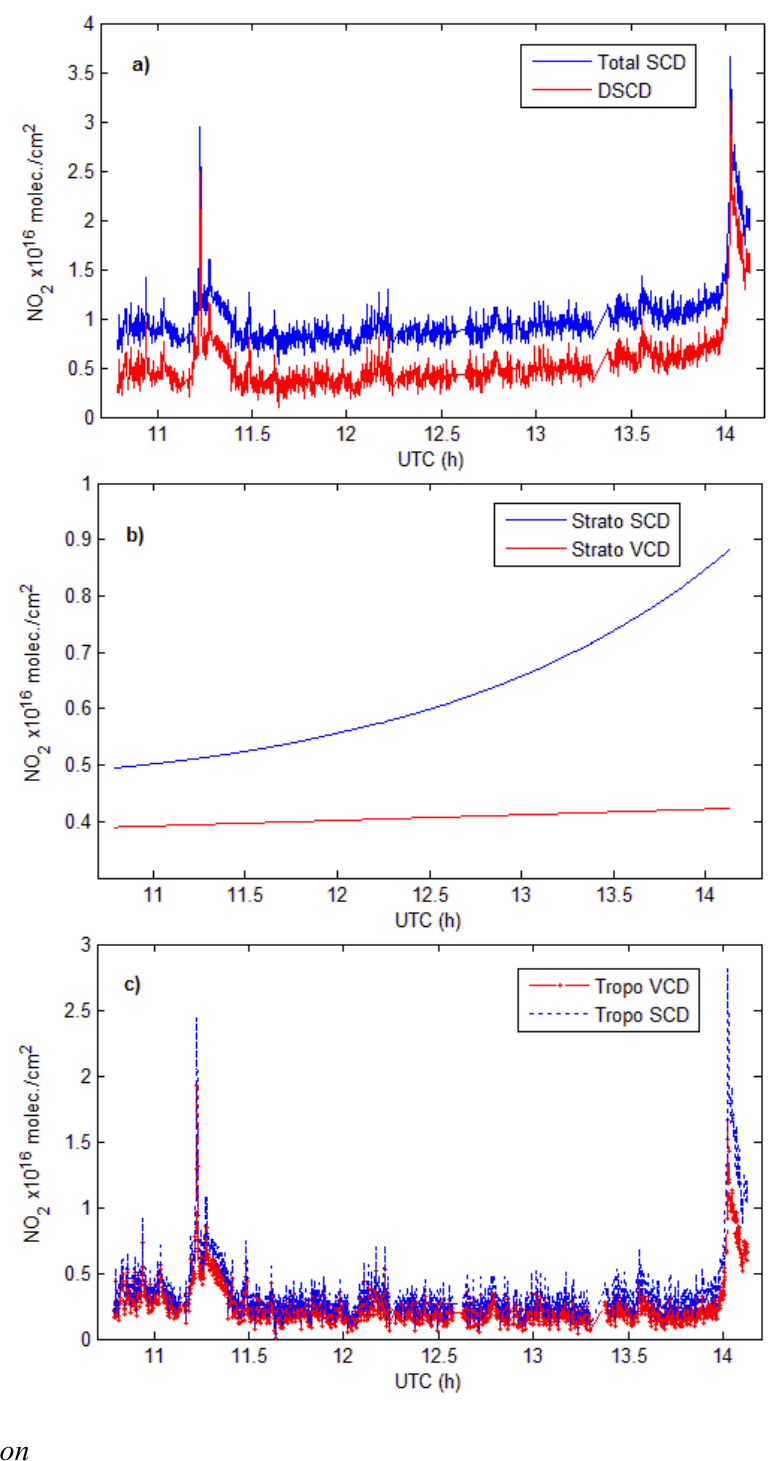
Figure 6. Time series of ( a ) DSCD and Total SCD; ( b ) Stratospheric SCD and VCD and; ( c ) Tropospheric SCD and VCD for 22 August